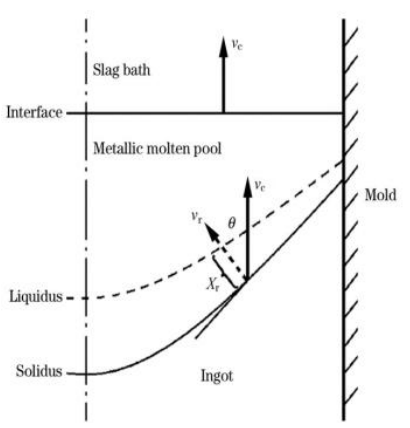
Figure 23. Relationship of local solidification time and cooling rate in ESR process.